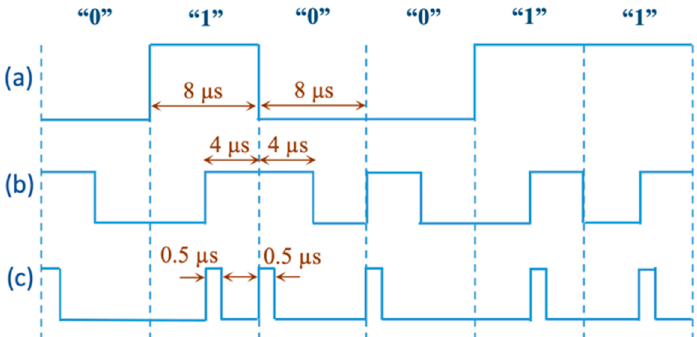
Figure 1. The block diagram of the near-field communication system for simultaneous wireless power transfer and telemetric acquisition of the gastric bioelectrical activity is